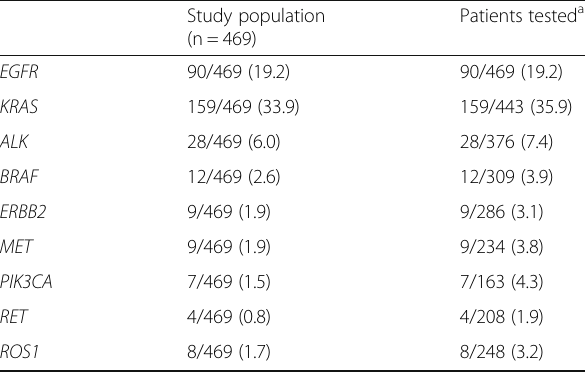
Patients tested a